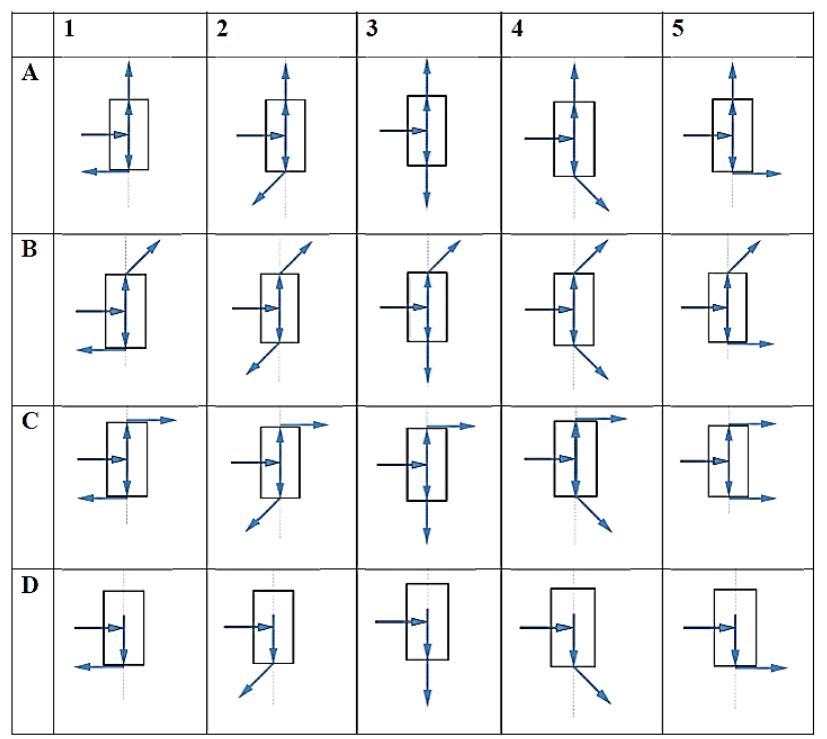
Table 2. Switchgear working